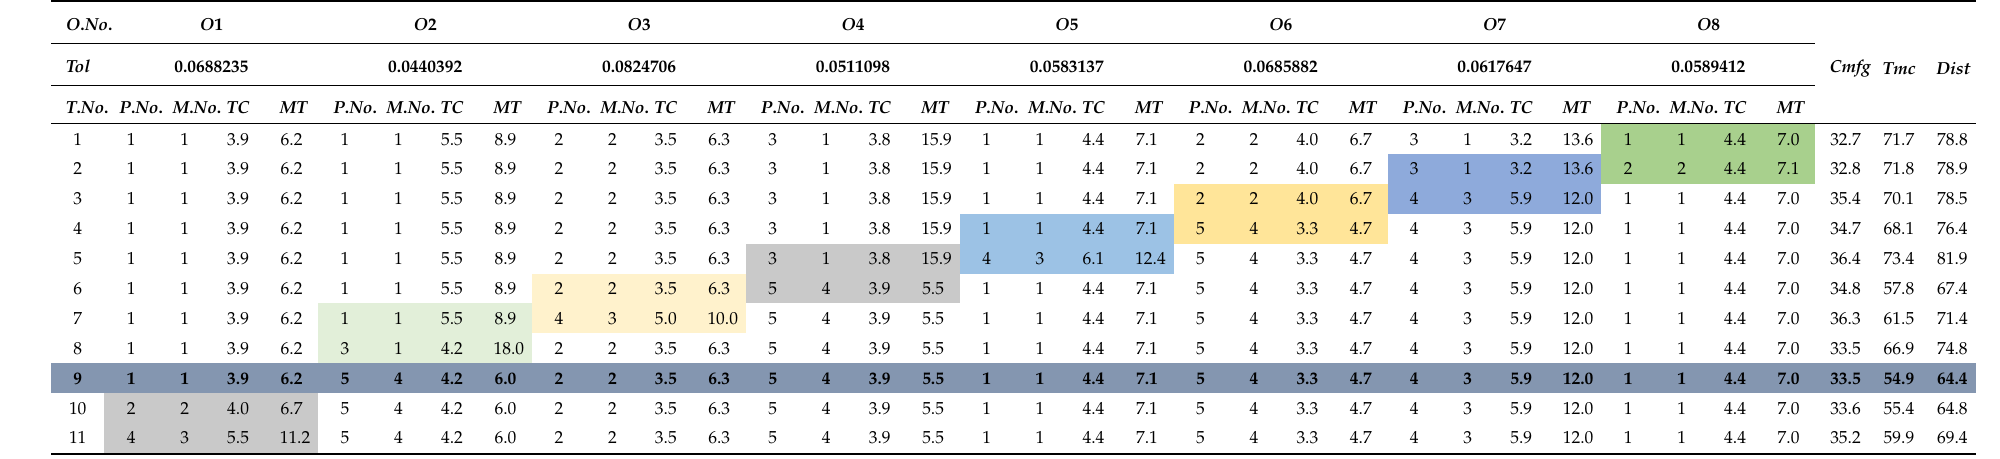
Table 3. Details of individual sub-stages of the existing problem presented in Table 11 Geetha et al. (2013) case